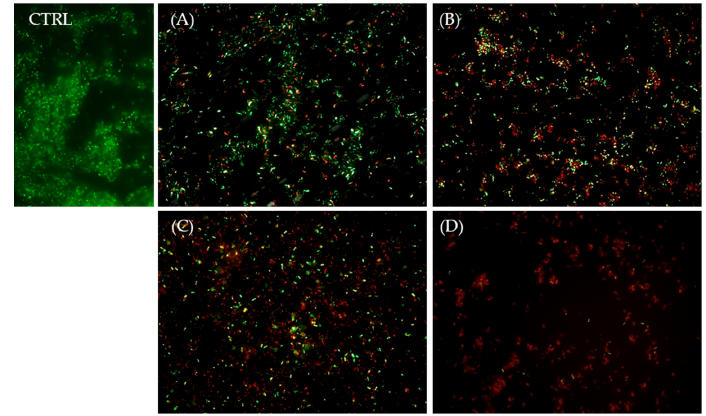
Figure 2. Representative images of dead/live staining of planktonic bacteria after treatment with: ( A ) UV 20 s, ( B ) Cl for 1 min, ( C ) combination of UV 5 s and Cl for 1 min, and ( D ) UV for 20 s and Cl for 1 min. CTRL represent control (untreated bacteria). Green fluorescence represents viable cells while red fluorescence indicates dead cells. Magnification 1000×.